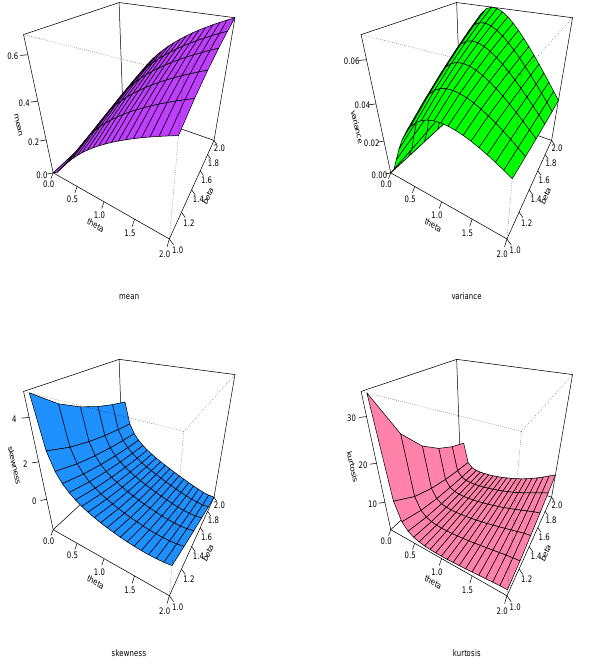
Figure 6. Three-dimensional plots of M ( X ) , Var ( x ) , CS ( x ) and CK ( x ) of the SBXLL distribution for θ =